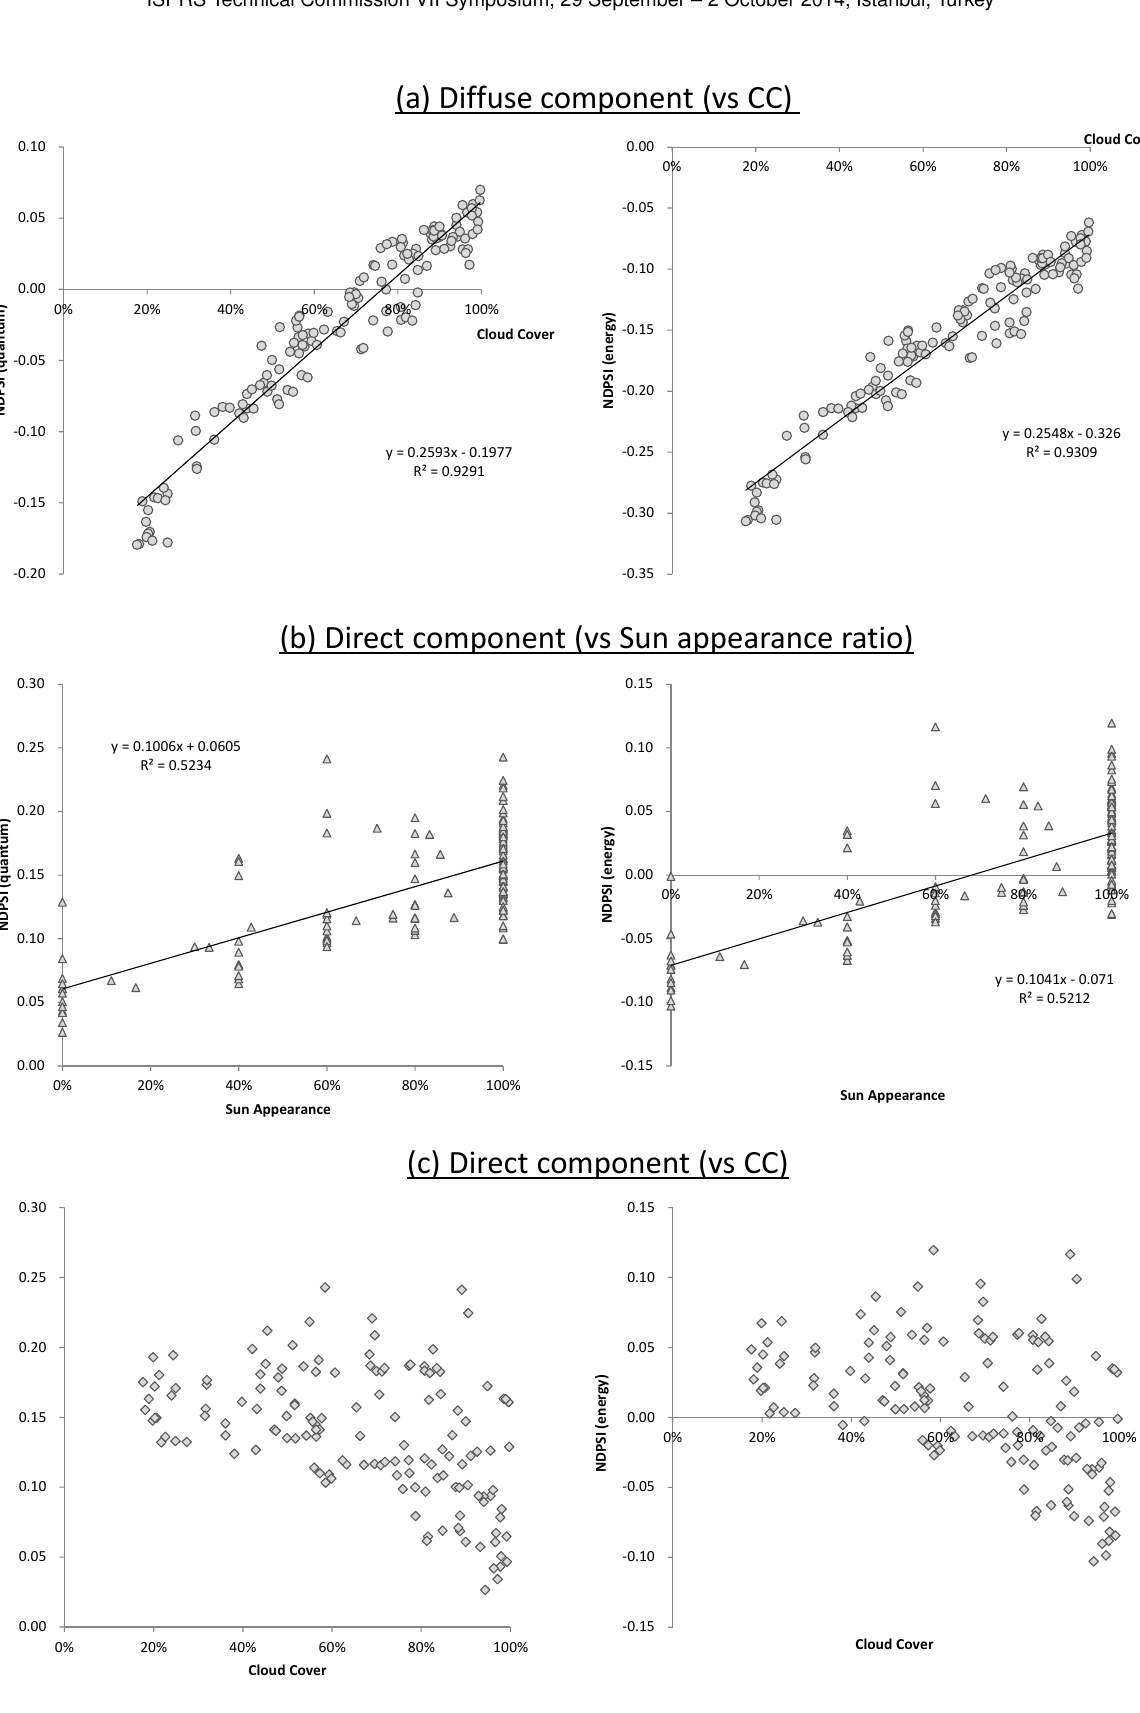
Fig. 5 The relationship between NDPSI with quantum and energy units and cloud conditions. (a) NDPSI vs cloud cover in diffuse component, (b) NDPSI vs the Sun appearance in direct component, and (c) NDPSI vs cloud cover in direct component.